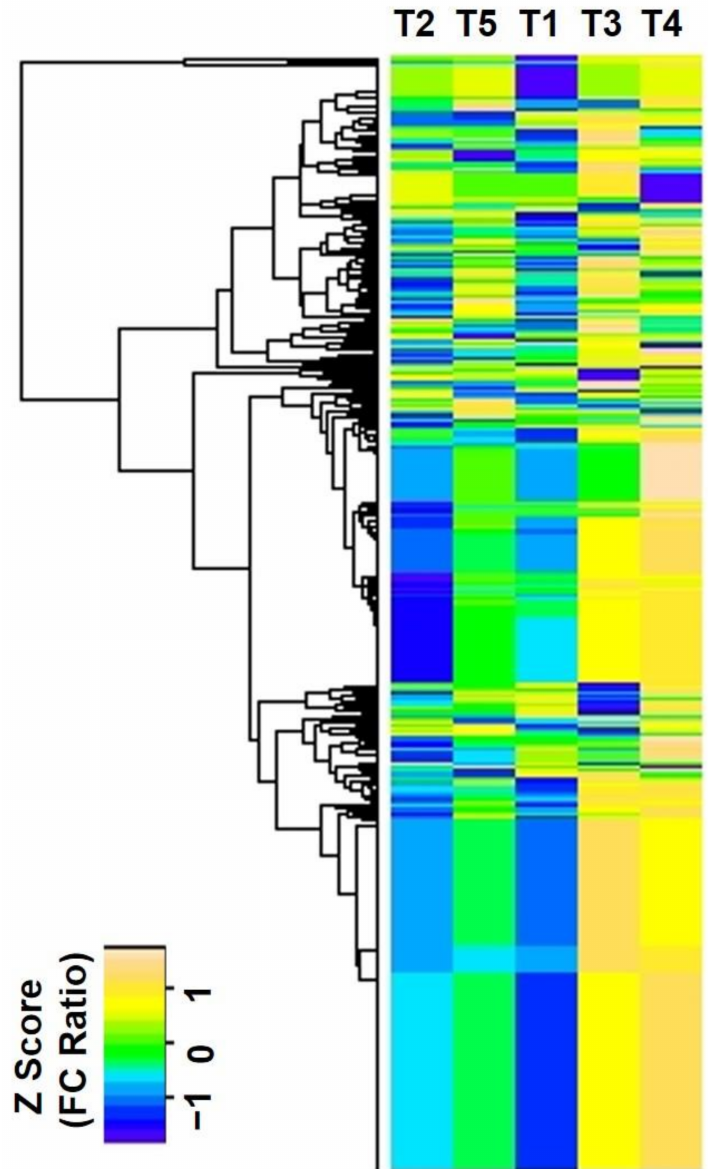
Figure 3. Heatmap analysis of the 426 differentially abundant proteins. Top, different treatments; left, protein tree. The color scale bar in the left, bottom corner indicates increased (yellow) and decreased (blue) levels of proteins in response to CA-mediated Cu